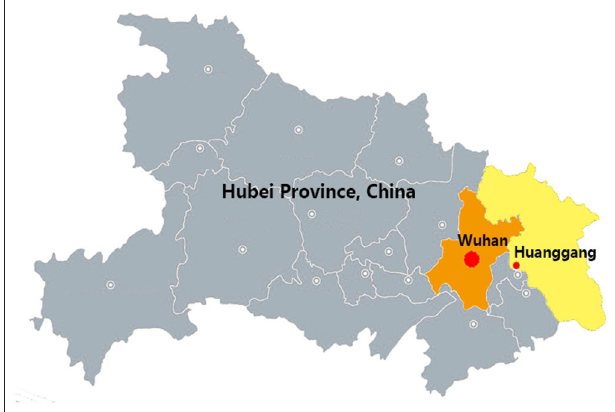
FIGURE 1 | Geographical location of Huanggang, where the respondents were